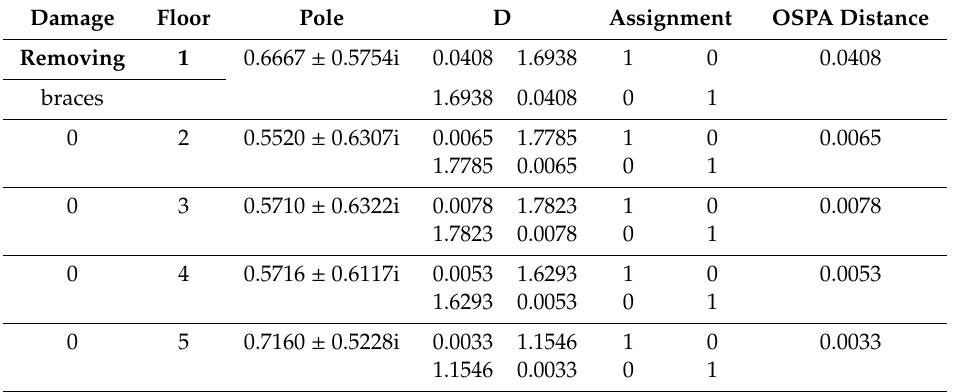
Table 6. OSPA distance and the corresponding parameters for the case of removing braces on the first